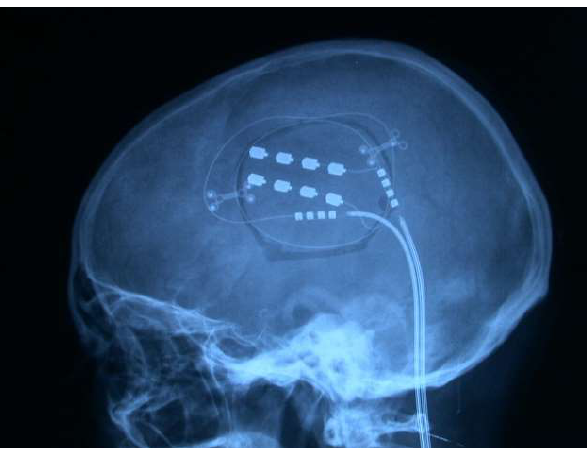
Figure 17. Control after placing epidural electrodes over the motor cortex.